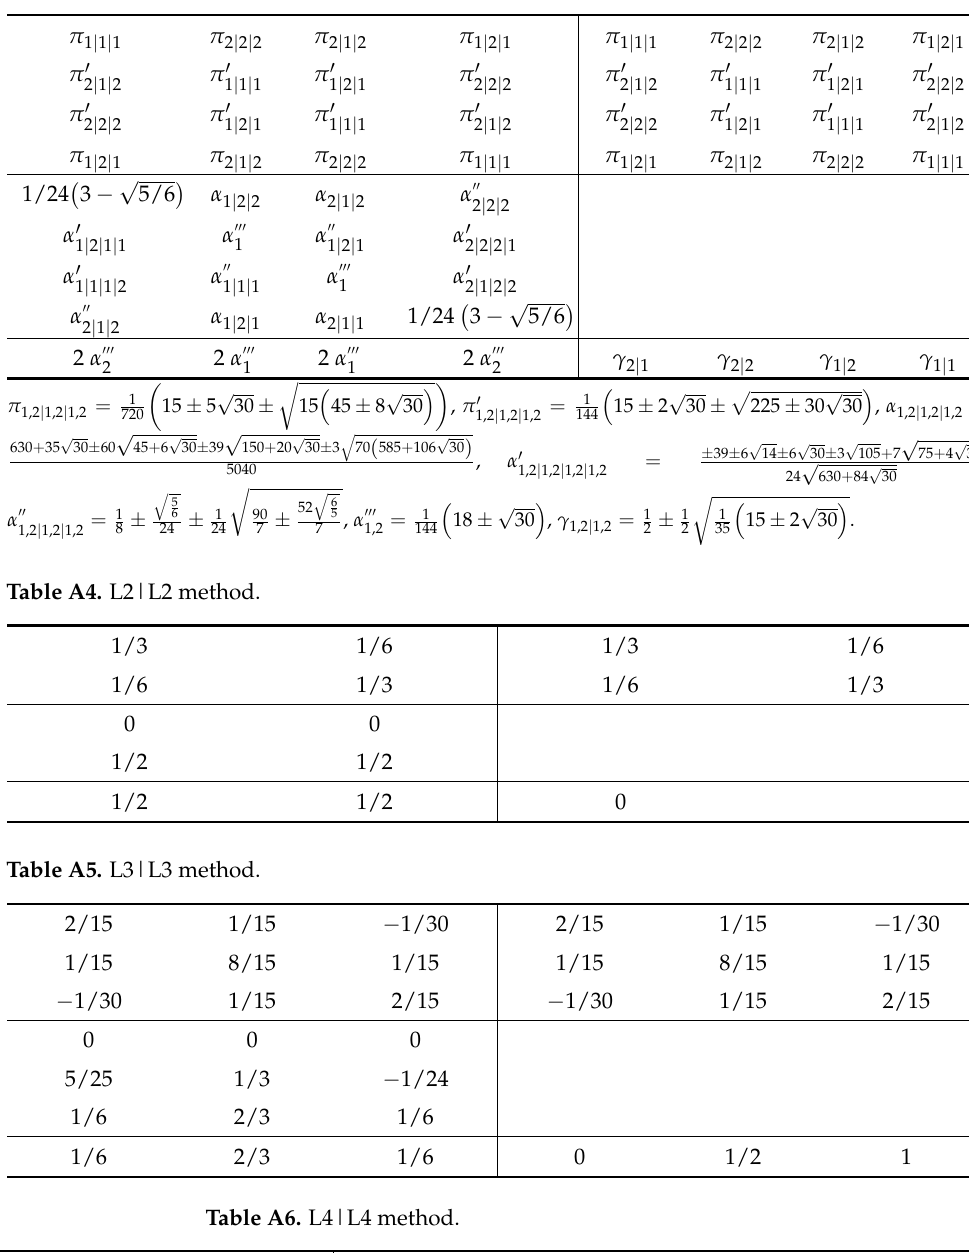
Table A3. G4|G4 method.